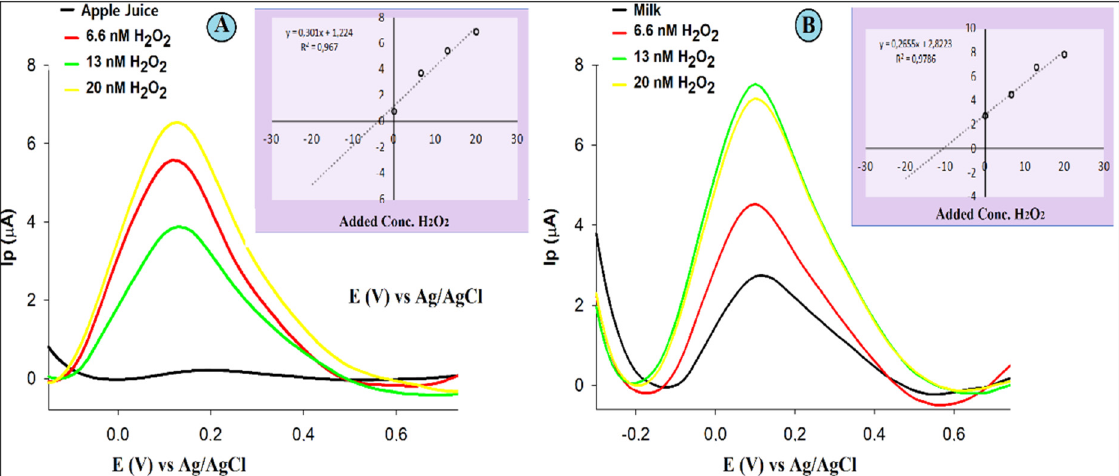
Figure 5. DPV measurements with GCE/SiO-CeONCs in 0.1 M PBS 0.01 for apple juice and milk sample before and after three successive additions of a standard solution of H 2 O 2 , and the insets are corresponding standard addition plots, apple juice ( A ) and milk samples ( B ).